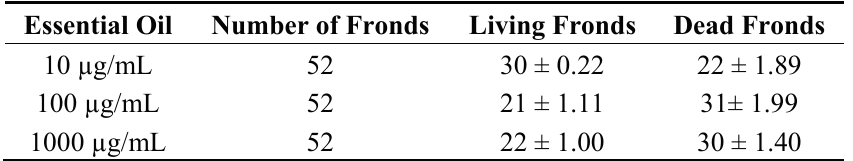
Data are the mean ±SEM of three replicates. Table 5. Cytotoxic effects of the essential oil of the leaves of Skimmia laureola . Essential Oil